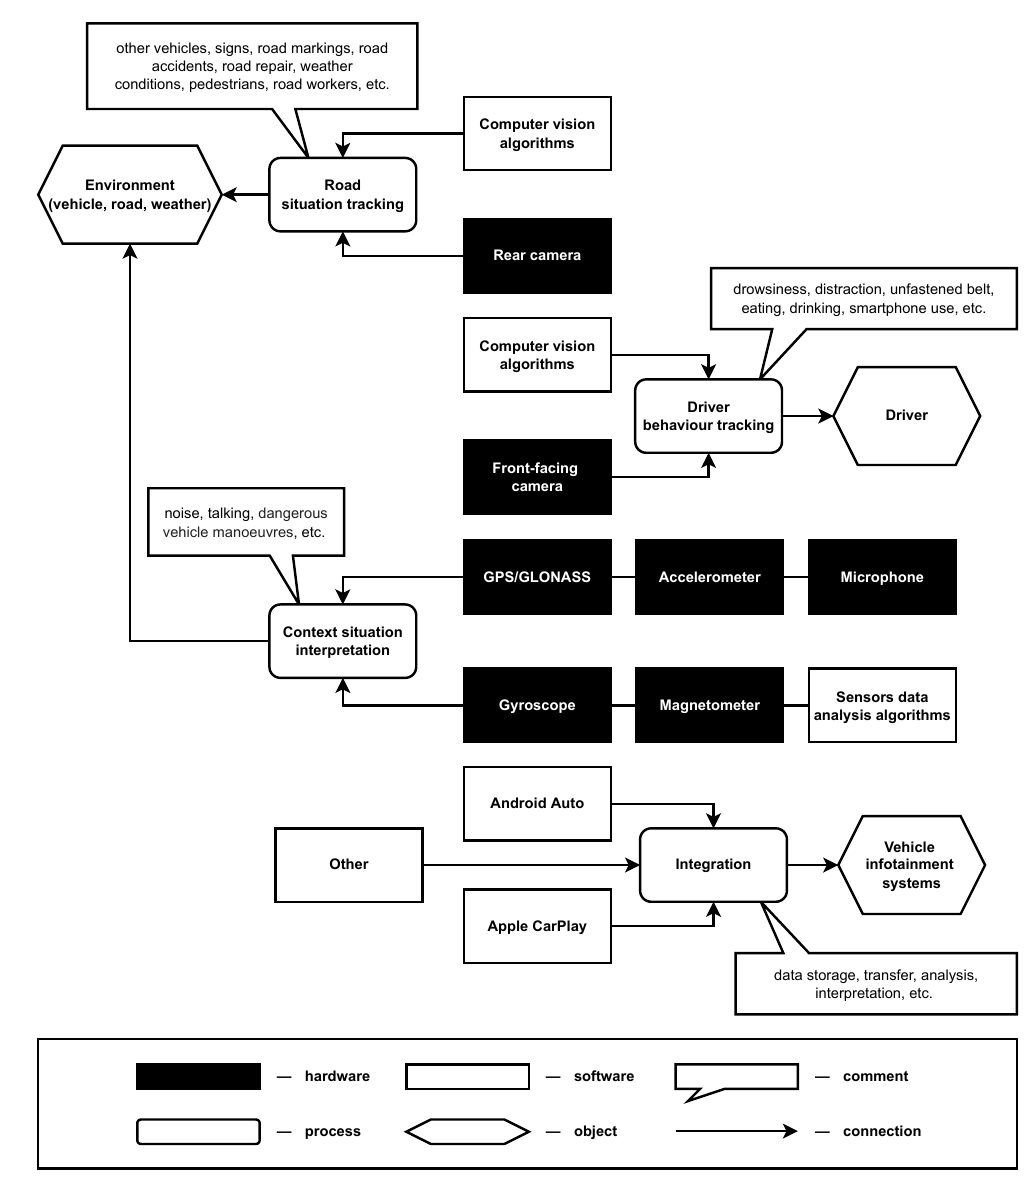
Figure 1. Structure of the smartphone-based driver monitoring